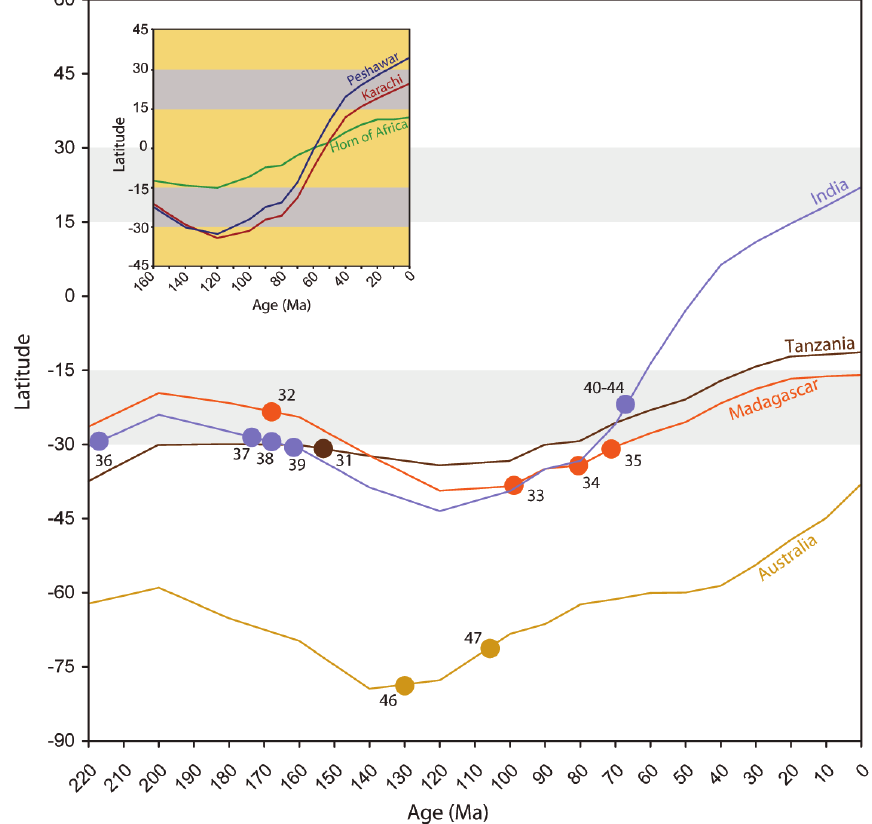
Fig. 6 – Latudinal trajectories of Gondwana dinosaur localities in the region of the Indian Ocean (localities listed by number in Table I). The inset shows the latitudinal trajectory of Karachi on the western margin of the Indian Subcontinent, of Peshawar near the Hindu Kush, and of the Horn of Africa, the easternmost part remaining of Greater Somalia. The trajectories cross in the early Paleogene indicating that the dispersal of dinosaurs from Africa to India by this route is unlikely if the points used accurately reflect